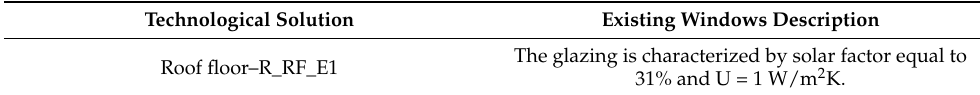
Table A20. Existing windows characteristics